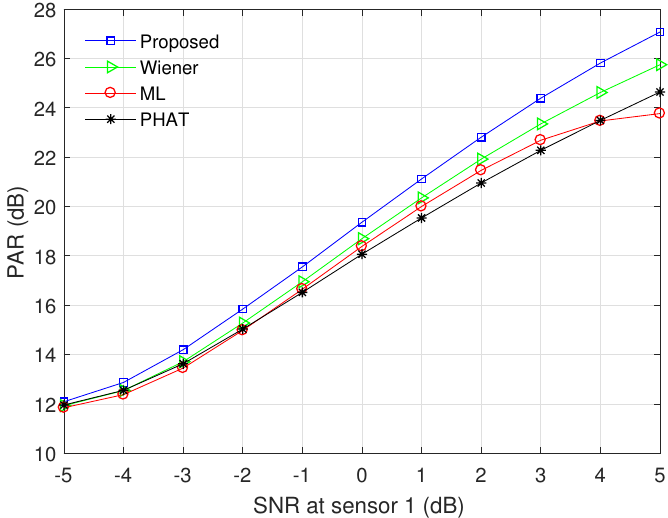
Figure 6. Peak-to-average ratio (PAR) of the time domain cross-correlation function for various prefilters, when α = 0.5, N = 4096, and M =